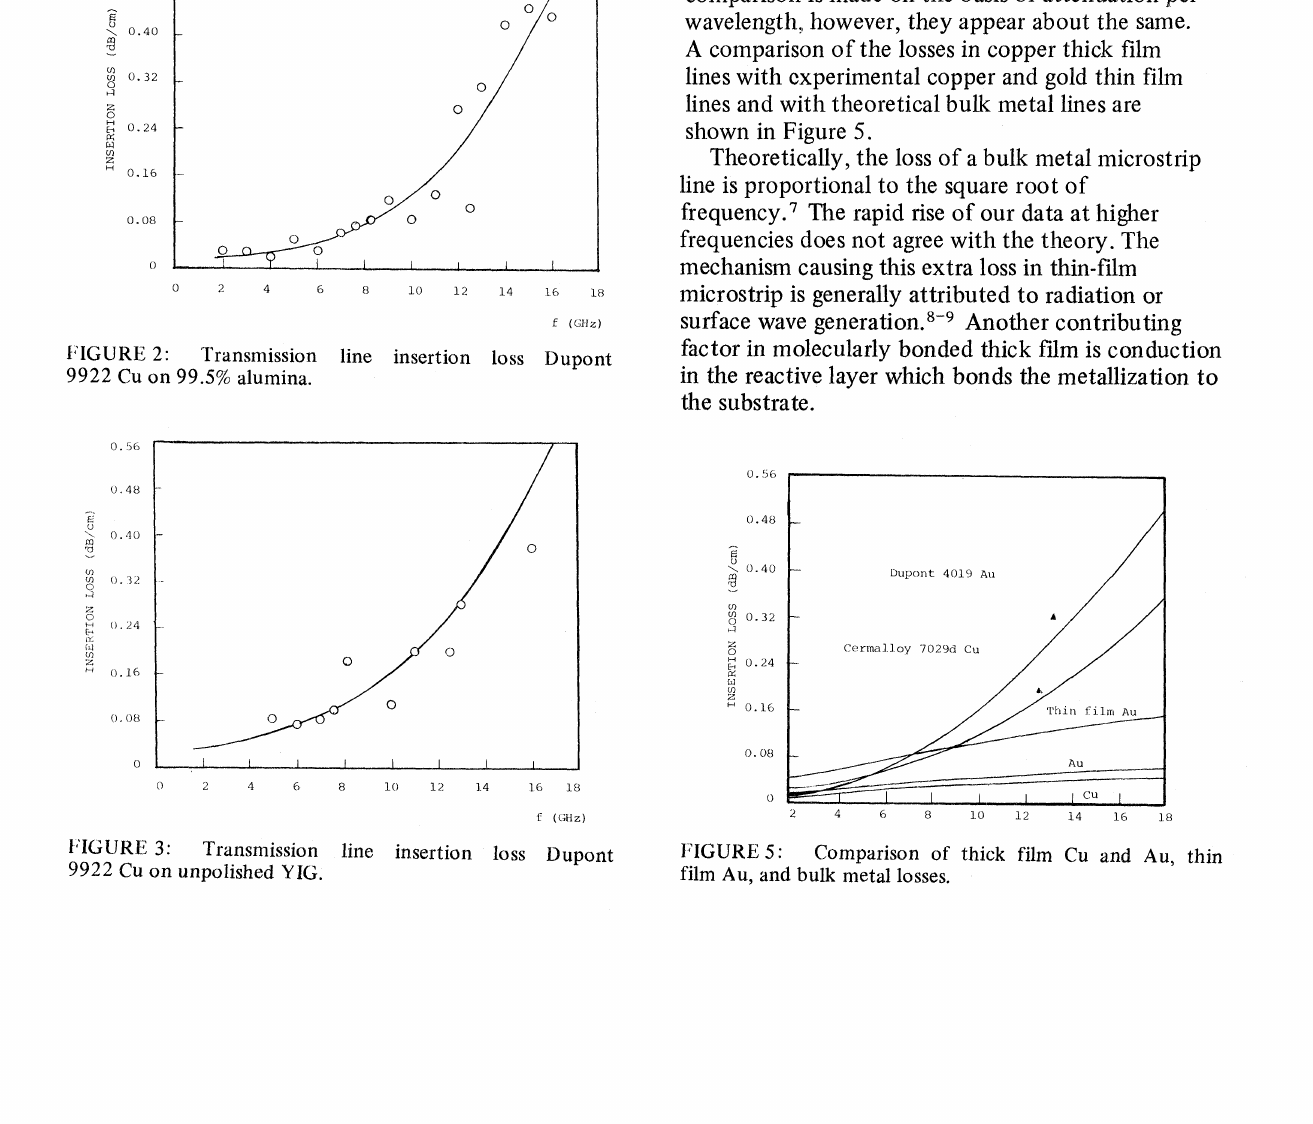
Transmission line insertion loss Dupont 9922 Cu on polished YIG.